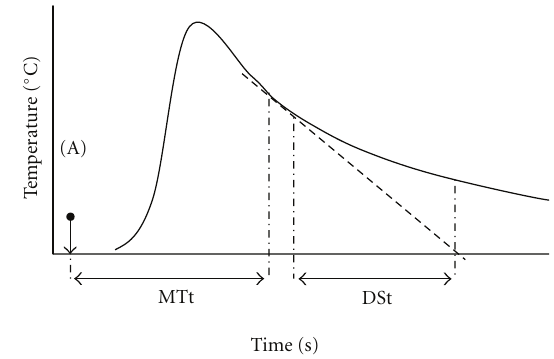
Figure 1: Thermodilution curves showing mean transit time (MTt) and downslope decay time (DSt) of the slope. The time point (A) represents the time of injection. The product of cardiac output and MTt equals the intrathoracic thermal volume. Multiplication of the cardiac output and the DSt equals the pulmonary thermal volume (PTV). The global end diastolic volume (GEDV) is equal to the ITTV − PTV. The intrathoracic blood volume = 1 . 25 × GEDV. The extravascular lung water (EVLW) is equal to the ITTV less the